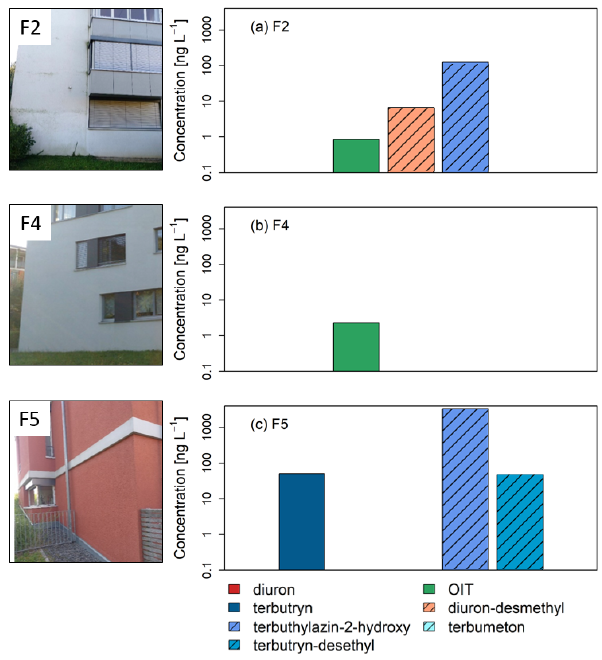
Figure 6. Photos of sampled facade sides and results of facade elu- tion experiments at houses 2, 4, and